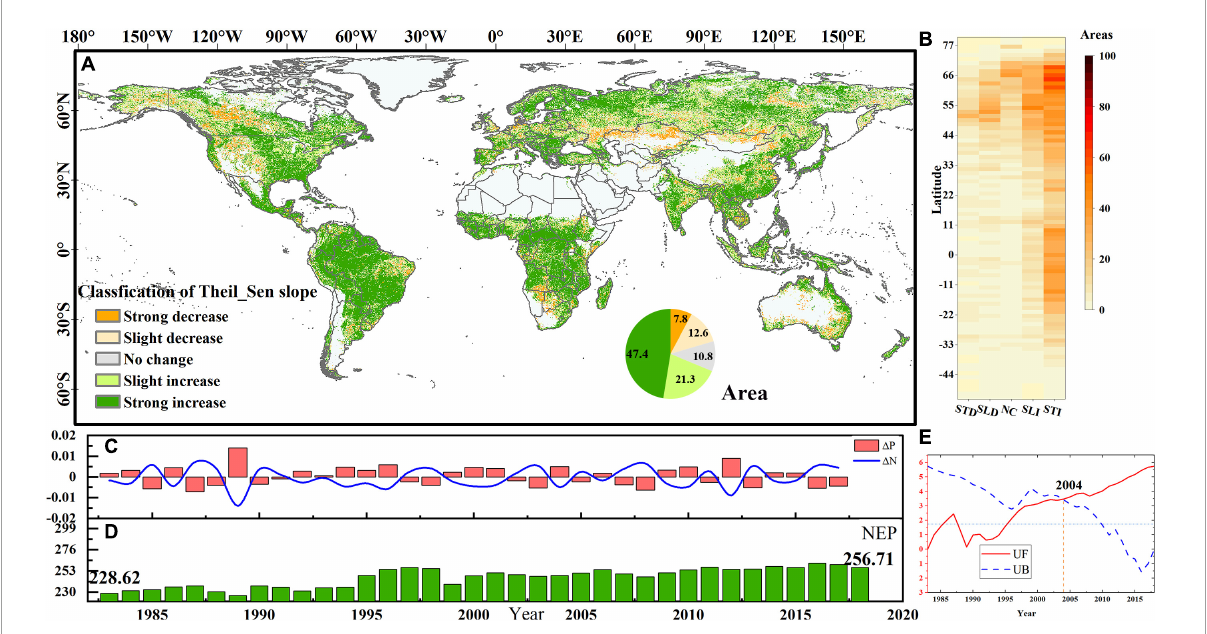
FIGURE1 The trend of NEP. (A) Spatial pattern of the Theil–Sen trend of NEP between 1983 and 2018; (B) latitude map of NEP trend in different classification, strong decrease is STD, slight decrease is SLD, no change is NC, strong increase is STI, and slight increase is SLI; (C) the (cid:49) P (the carbon sink areas difference between the current year and the previous year) and (cid:49) N (the carbon source areas difference between the current year and the previous year) and (D) the mean value of NEP; (E) the Mann–Kendall mutation test of